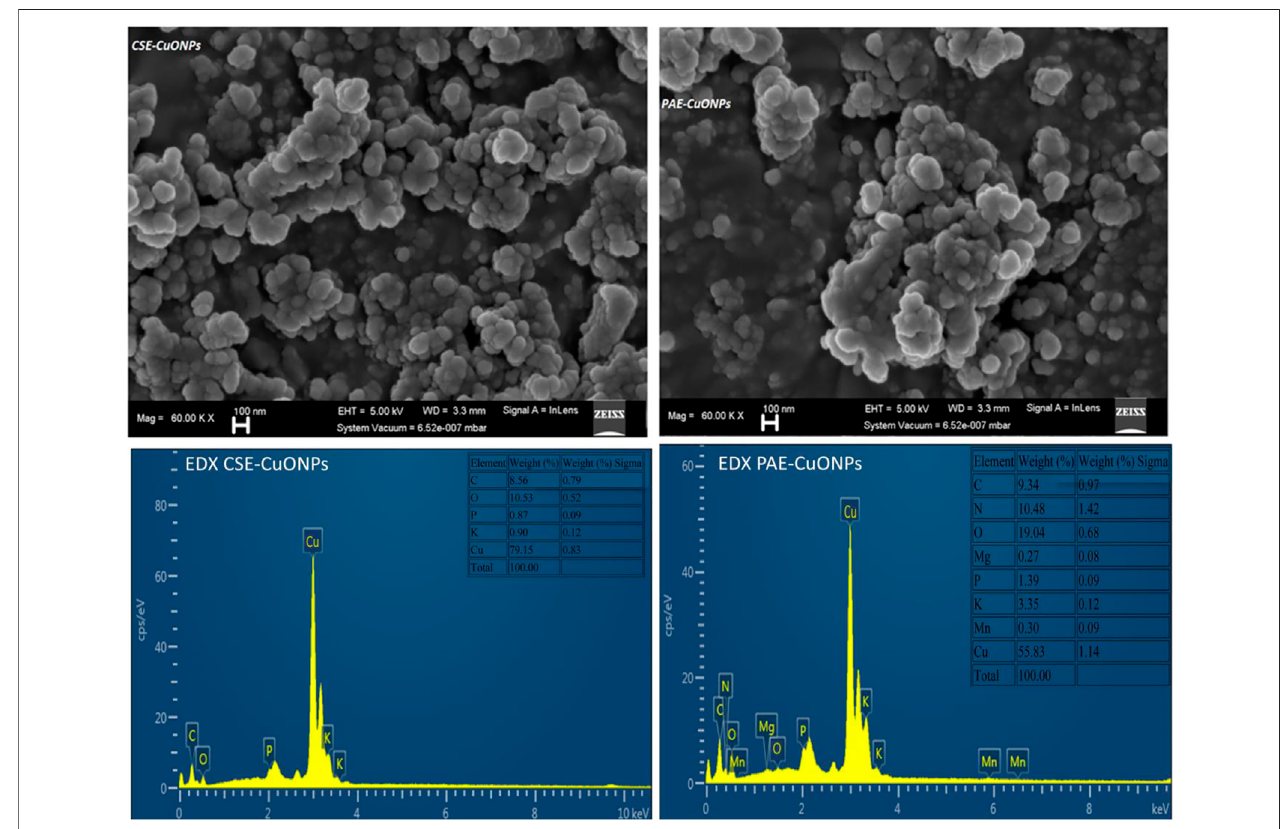
TABLE 3 | MIC and MBC values of biosynthesized CuONPs against Carbapenem-resistant and sensitive E. coli and K. pneumoniae . Bacteria type PAE-CuONPs CSE-CuONPs MIC (µg/ml) MBC (µg/ml) MIC (µg/ml) MBC (µg/ml) Carbapenem resistant E. coli 125 a 250 ab 125 a 250 ab Carbapenem resistant K. pneumoniae 125 a 250 ab 125 a 250 ab Methicilin reistant Staphyloccocus aureus 30 c 125 d 30 c 125 d Mean values in each column accompanied by the same letter are not signi fi cantly different ( p > 0.05) (Tukey Multiple Comparison), and values accompanied by letter (s) which are not similar are signi fi cantly different ( p < 0.05). MIC, Minimum inhibitory concentration, MBC, Minimum bactericidal concentration, PAE-CuONPs, Prunus africana extract